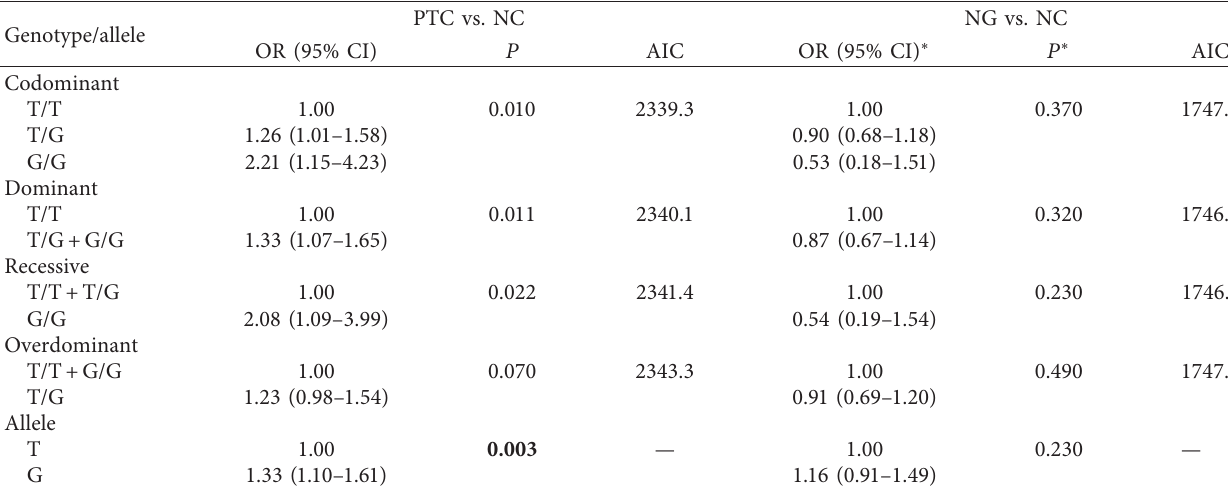
Table 5: Association between rs1443434 polymorphism and PTC/NG.